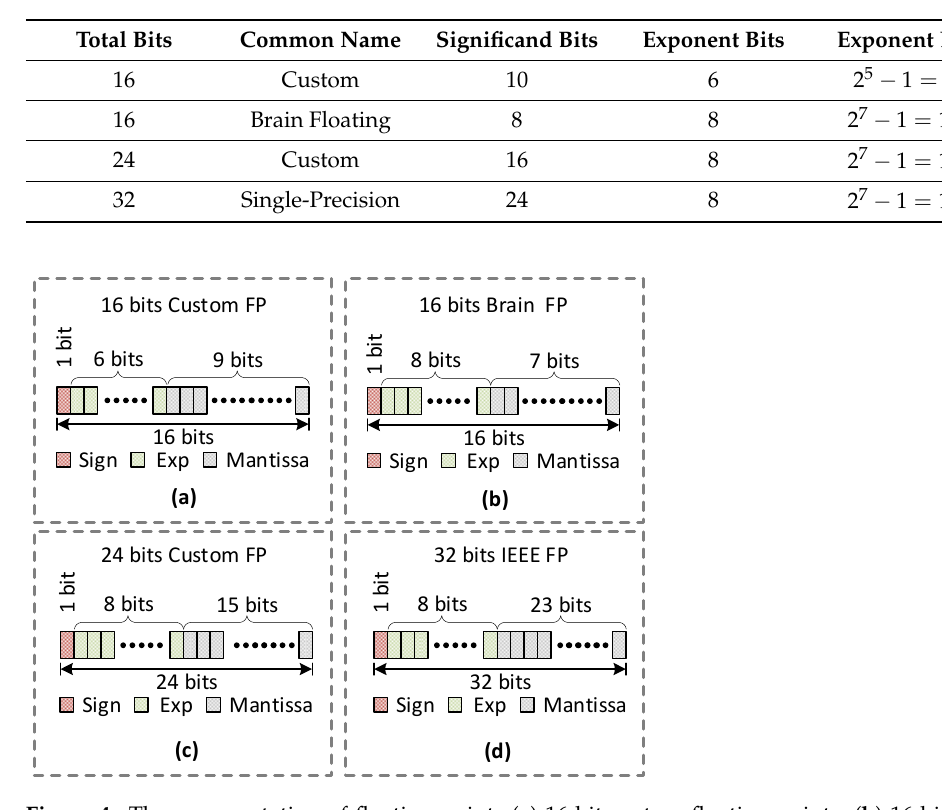
Table 1. Formats evaluated in CNN.